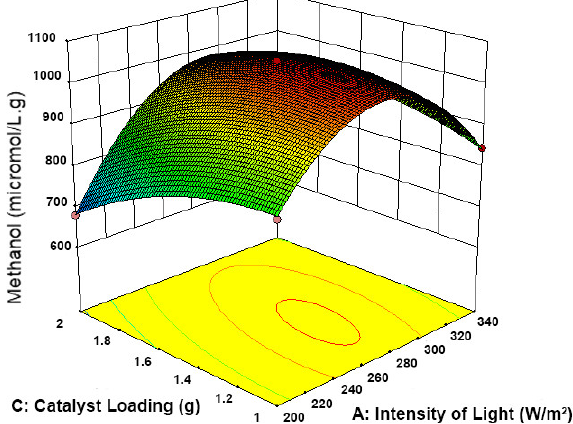
Figure 12 Figure 12. Effect of the intensity of light and catalyst loading on methanol